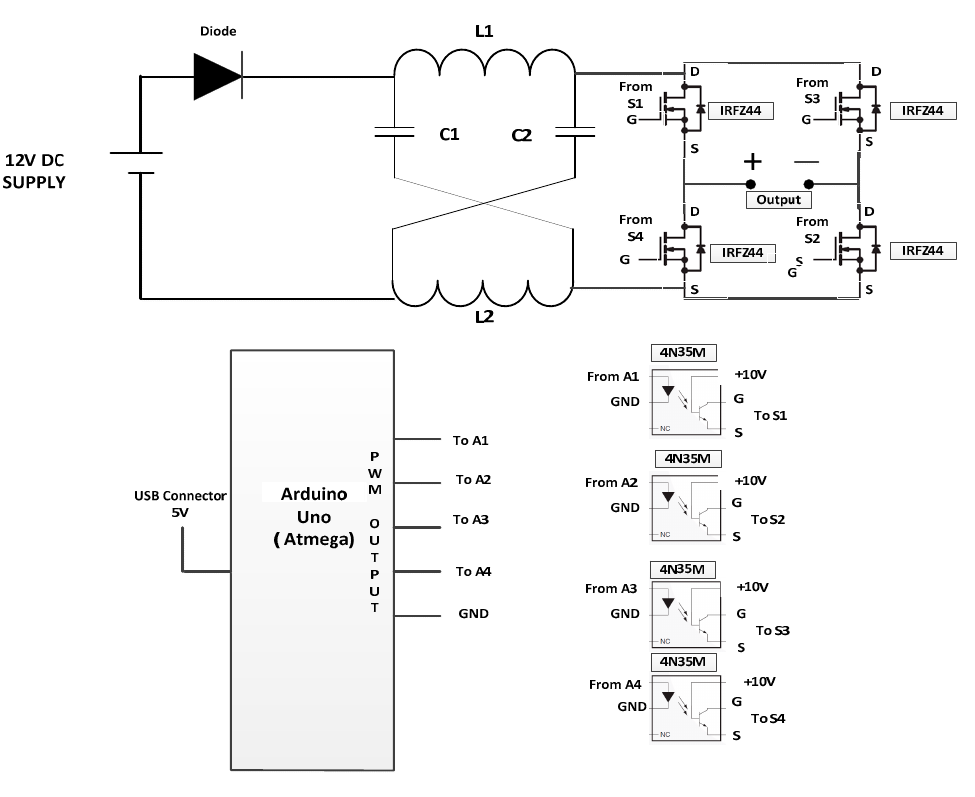
Figure 9. Hardware setup.